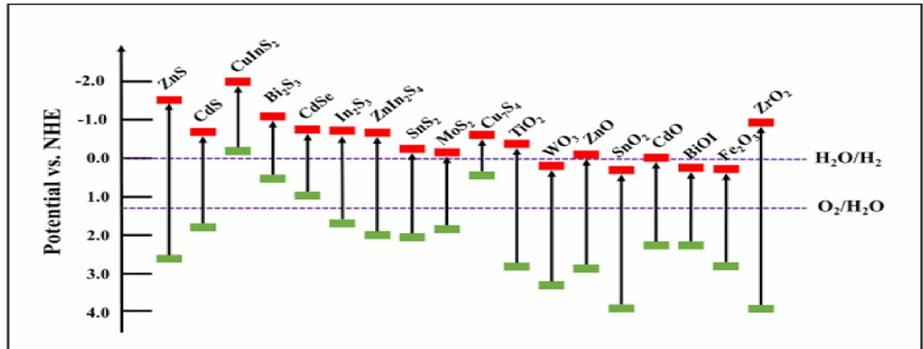
Figure 5. The band structure of common metal sulfide and metal oxide semiconductors (reprinted with permission, copyright Elsevier (2021))